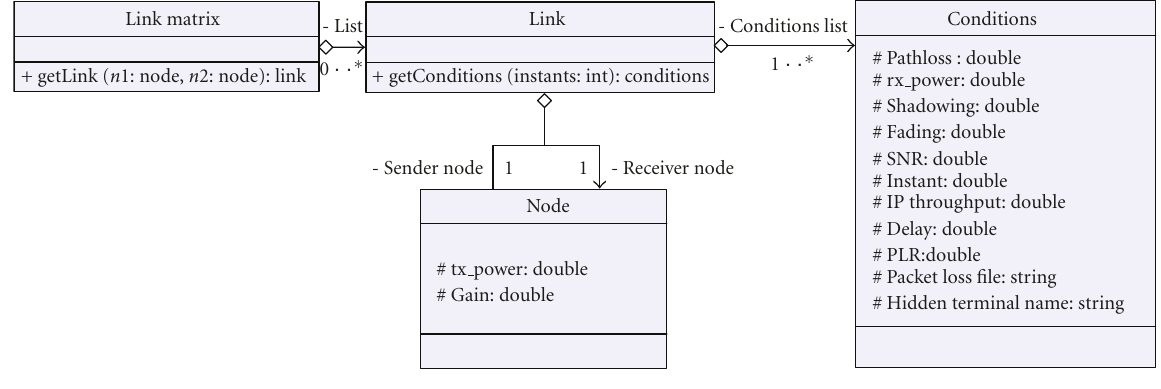
Figure 7: An excerpt of class diagram focusing on the link matrix.